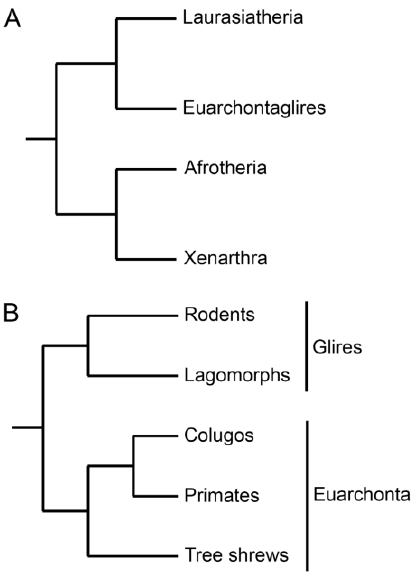
Figure 1. The mammalian tree. ( A ) The four major clades of eutherians [8]. ( B ) The orders of Euarchontoglires [9]. Note the separation of Glires (including rodents) from Euarchonta (including primates). There are alternative interpretations of the root of the tree and the position of tree shrews. Reprinted with permission from [2] © 2021 Society for Reproduction and Fertility.